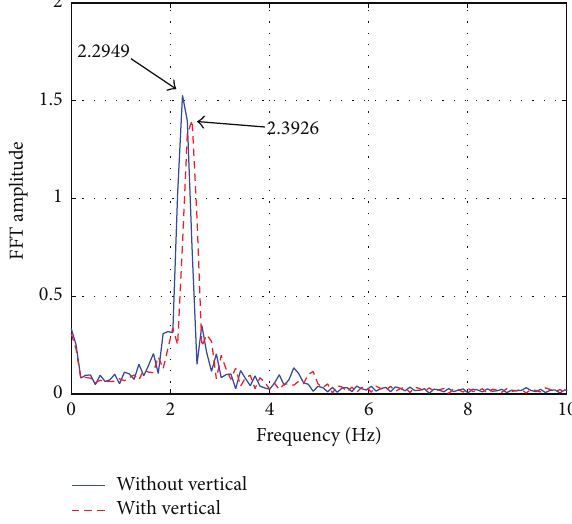
Figure 15: Comparison of the sloshing frequency under vertical acceleration.